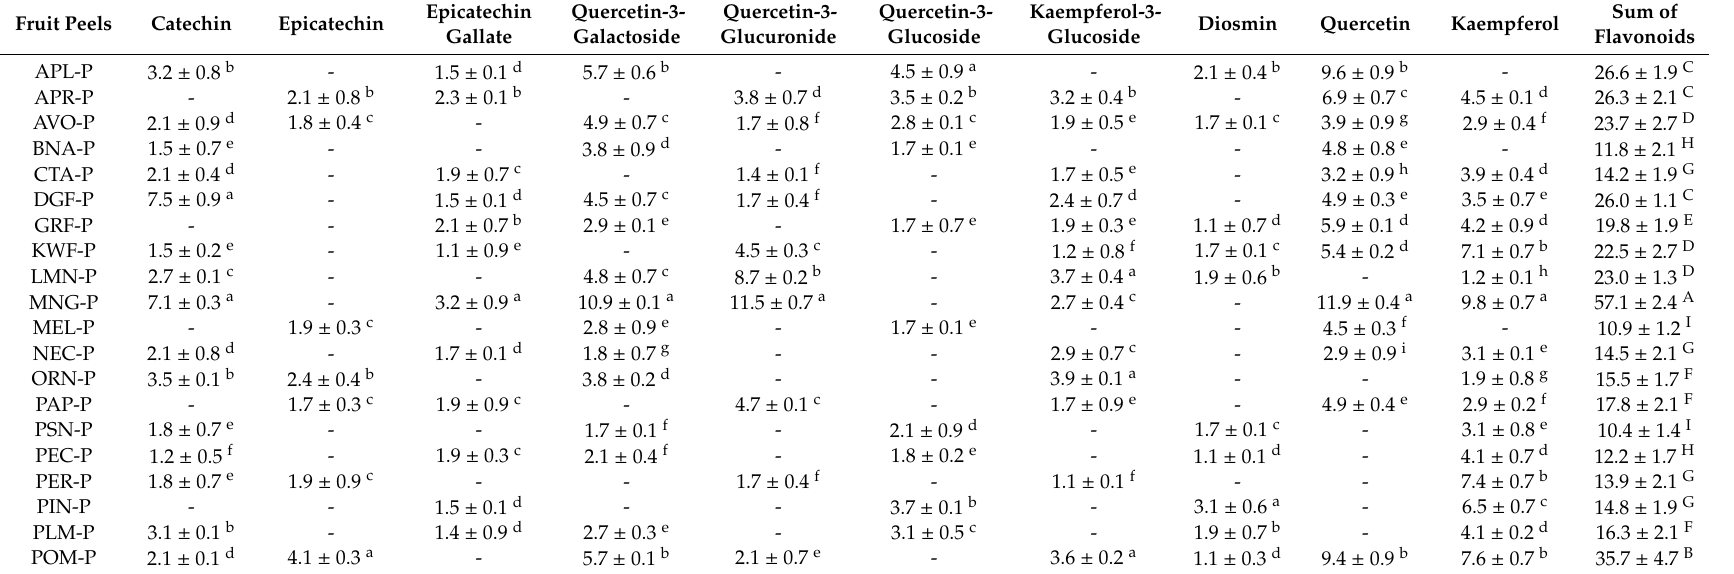
Table 3. Flavonoids quantified in di ff erent fruit peel samples using